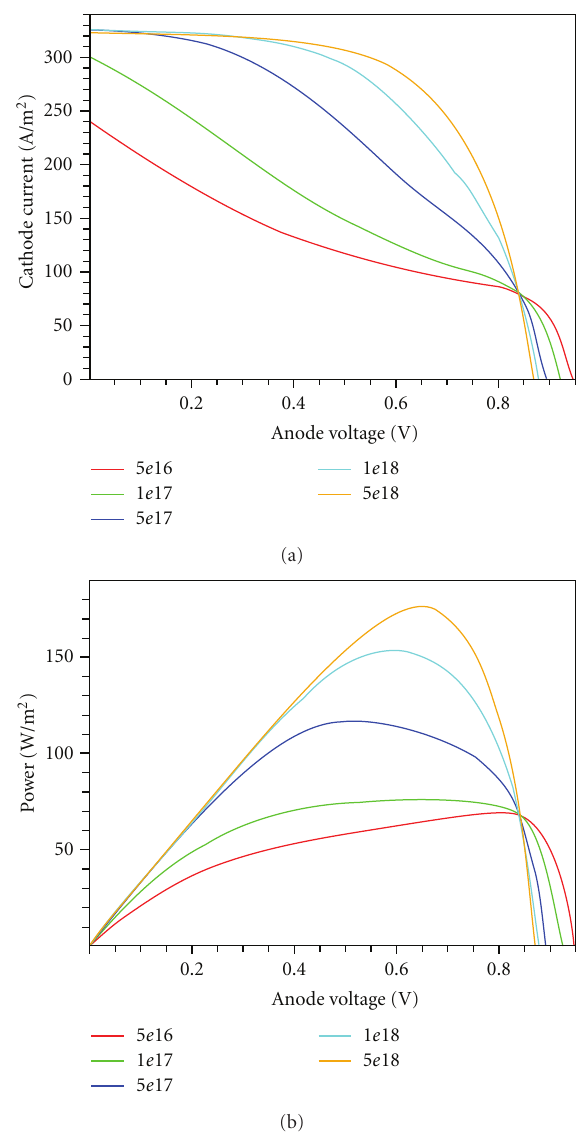
Figure 2: I-V and P-V curves of the a-SiGe:H single junction solar cell as a function of acceptor concentration in p-layer.